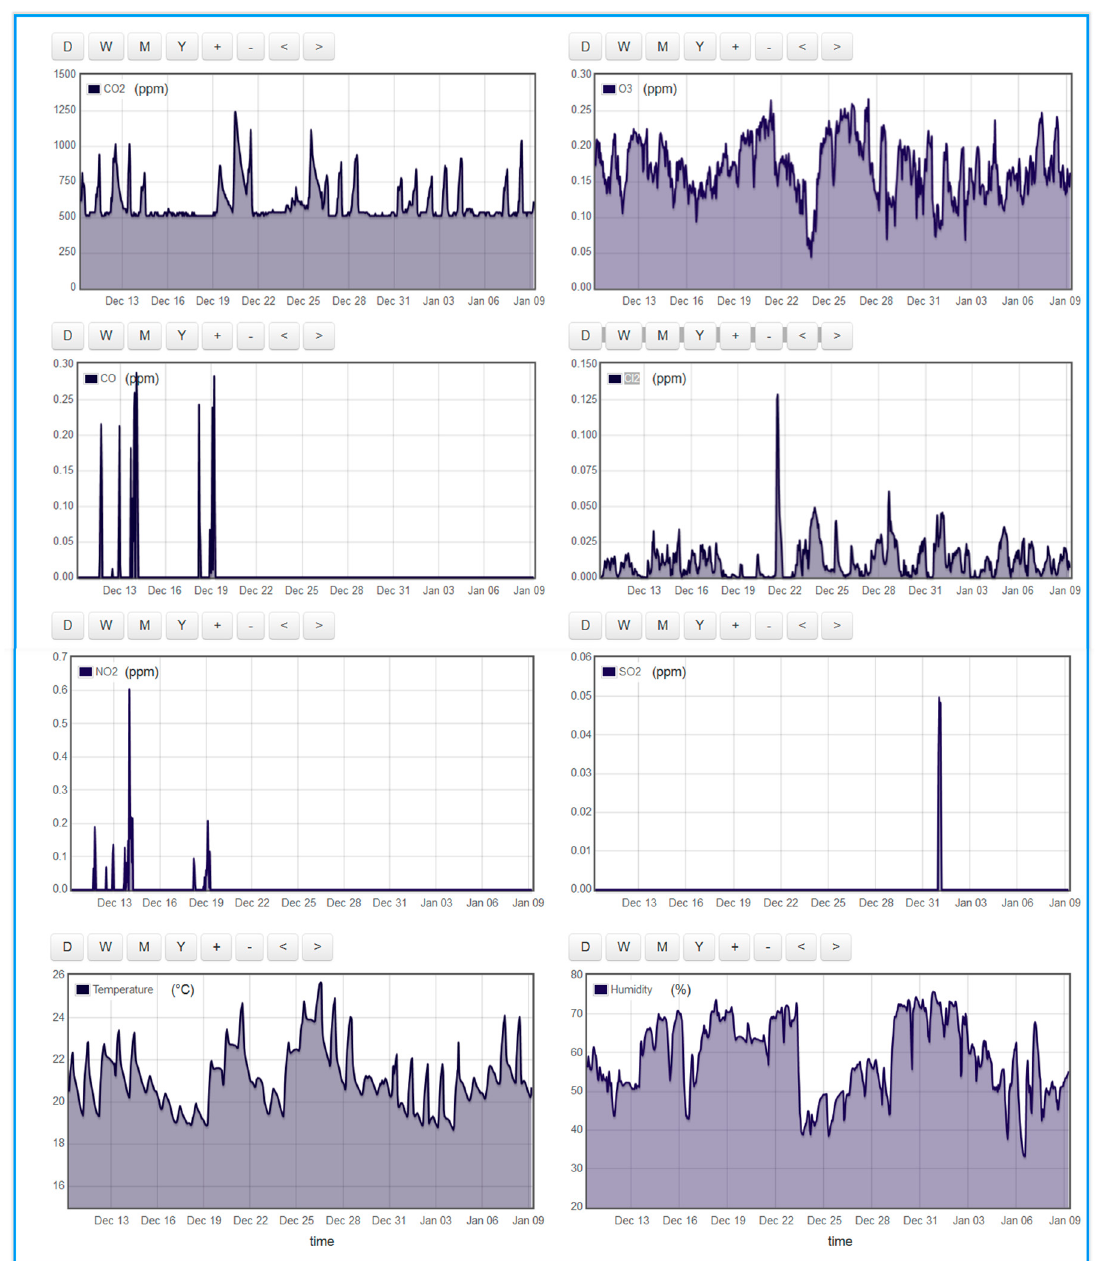
Figure 13. Emoncms IoT-displayed indoor air quality data collected in a Chemical Engineering research lab of Qatar University (9 December 2017 to 9 January 2018).